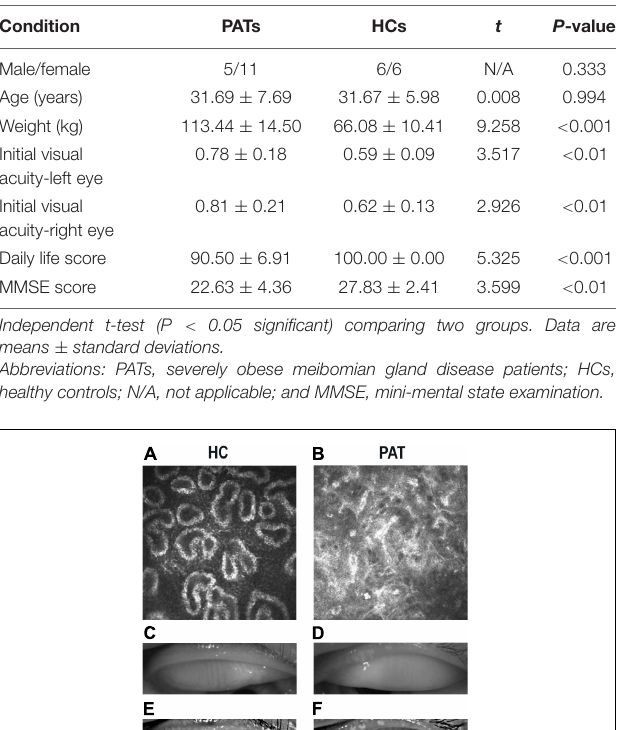
TABLE 1 | Characteristics of participants in the study.